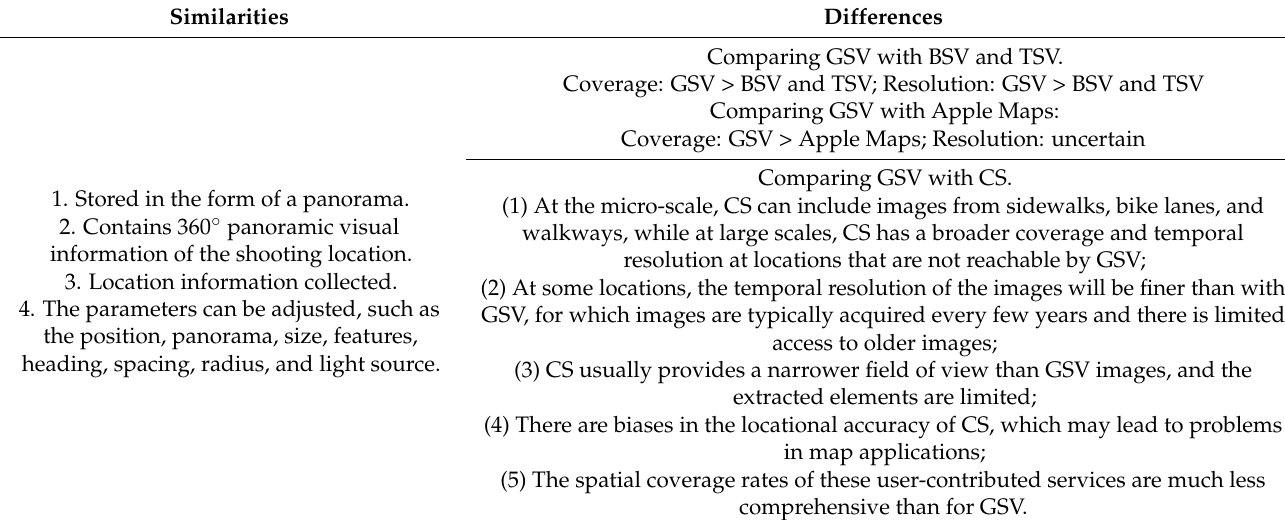
Table 2. The main comparison of the three types of services.